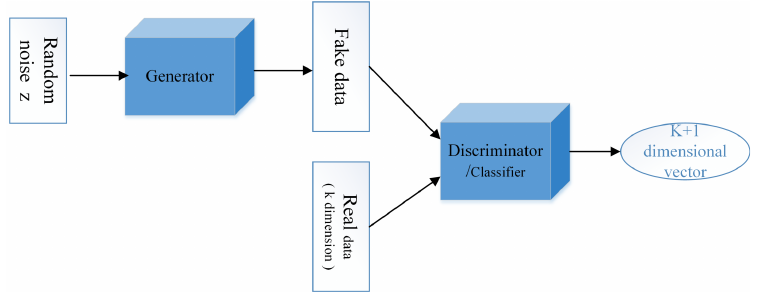
Figure 7. Basic structure of